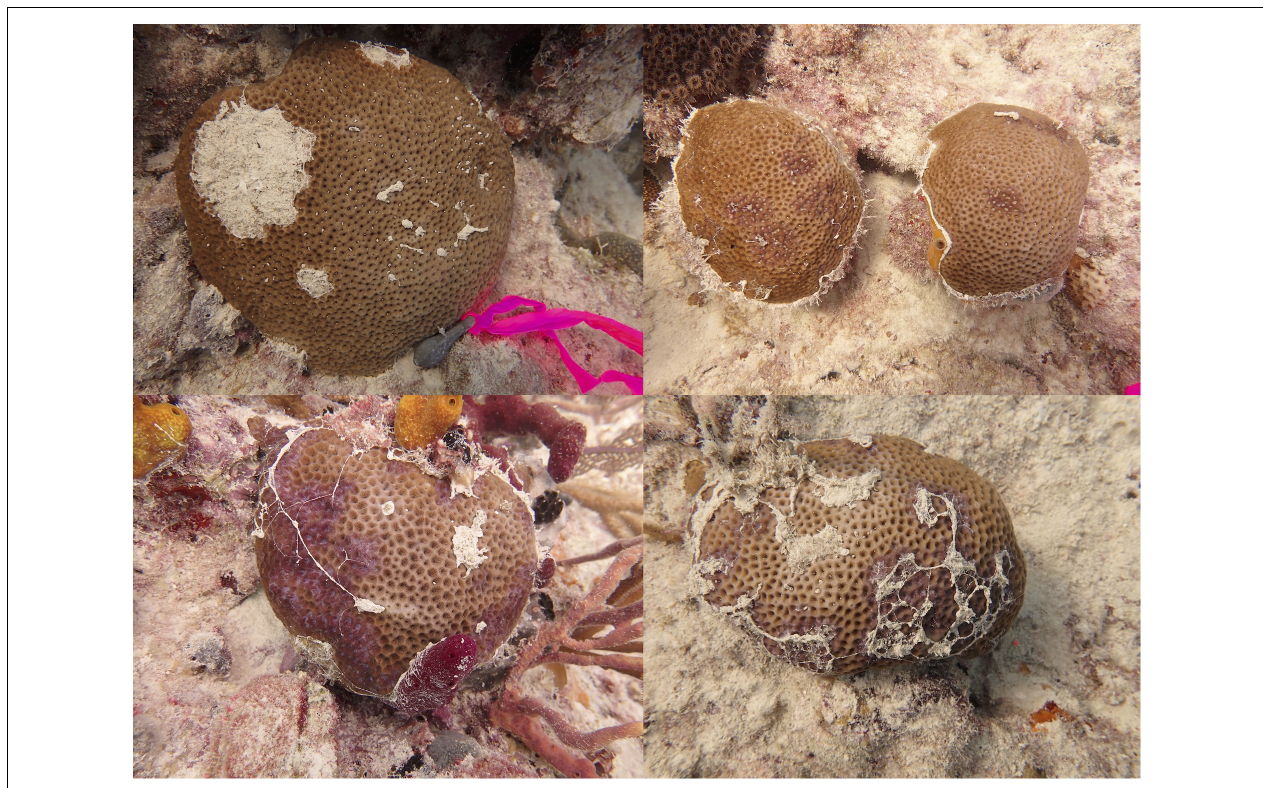
FIGURE 4 | Examples of lesions found on S. siderea from the Lower Keys. Lesions may or may not be indicative of